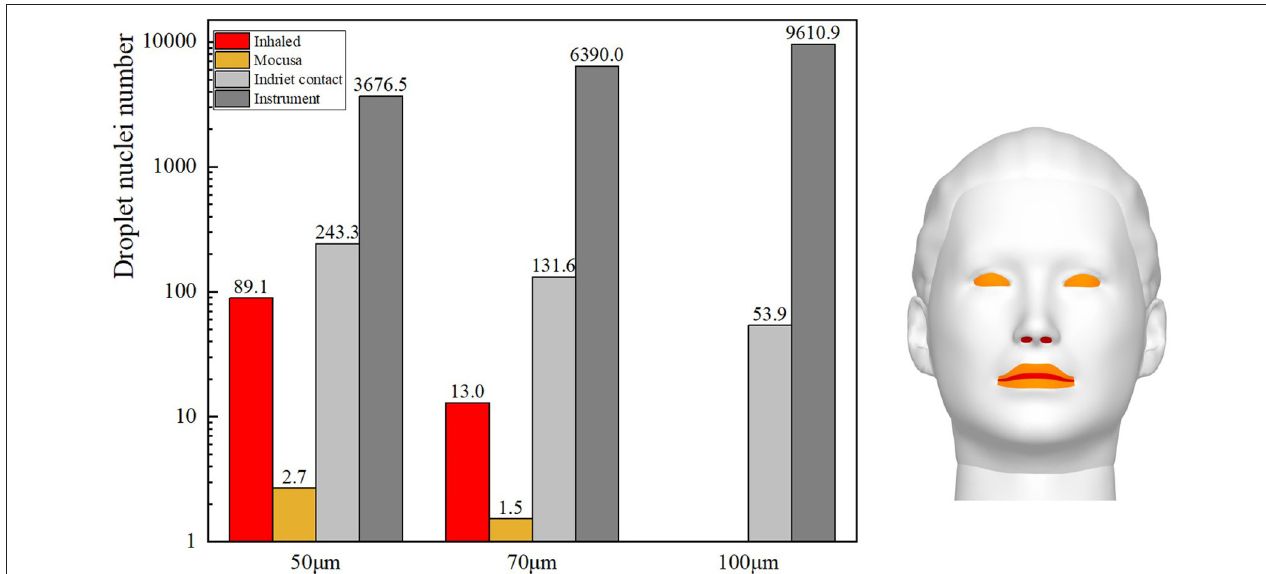
FIGURE 11 | Exposure of ophthalmologists to initial droplets with diameters of 50, 70, or 100 µ